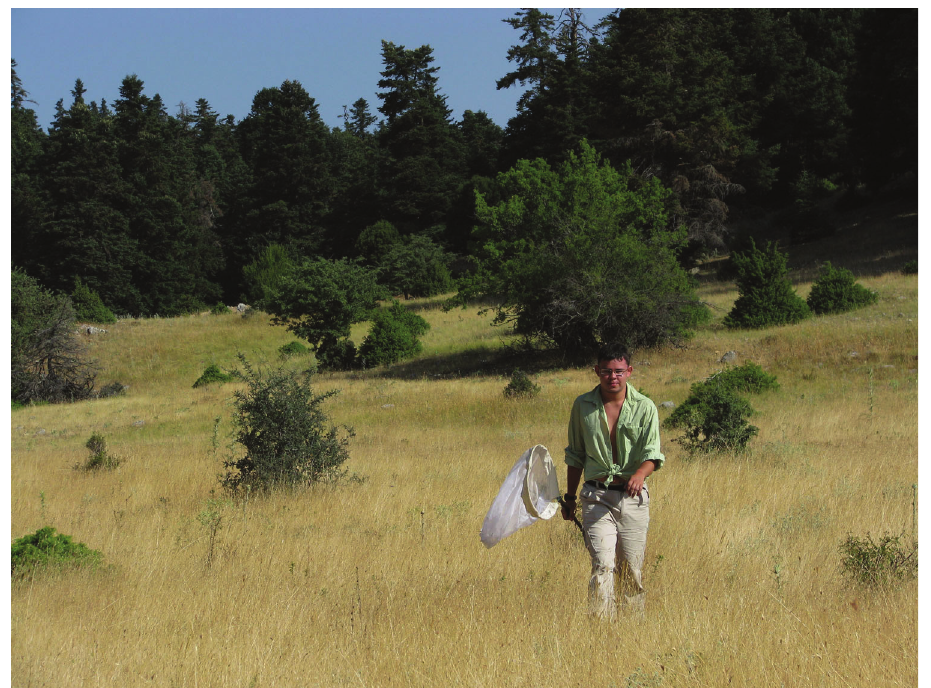
Figure 35. Habitat of P. timfristos . Central Greece, Mt. Parnassos, 19 July 2008. Photo by V.A. Lukhtanov.